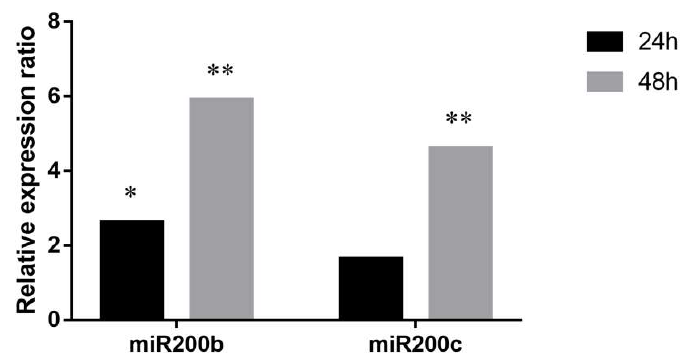
Figure 5. Relative expression ratios of miR200b and miR200c in A2780 cells co-cultured with PEO1. Relative expression ratio was calculated relative to the expression values of A2780 cultures without co-culturing (1). Ratio > 1 indicates upregulation relative to the non-co-cultured cell. Significance was determined between the ΔCT values of treated and non-treated samples: * p < 0.05; ** p < 0.01.